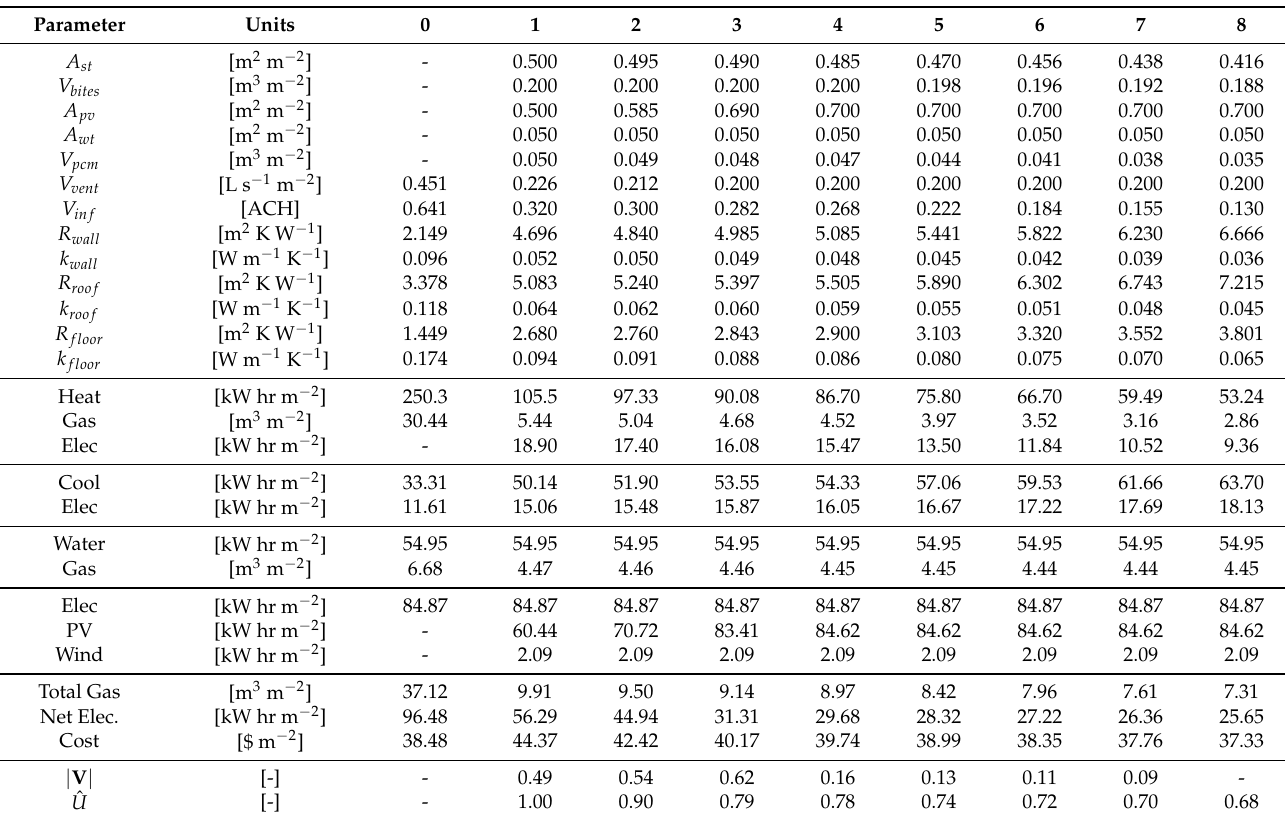
Table 6. System design parameters and building performance metrics for the base case 0 (no renewable/alternative energy), initial case 1 (renewable/alternative energy), and the subsequent cases toward optimization.